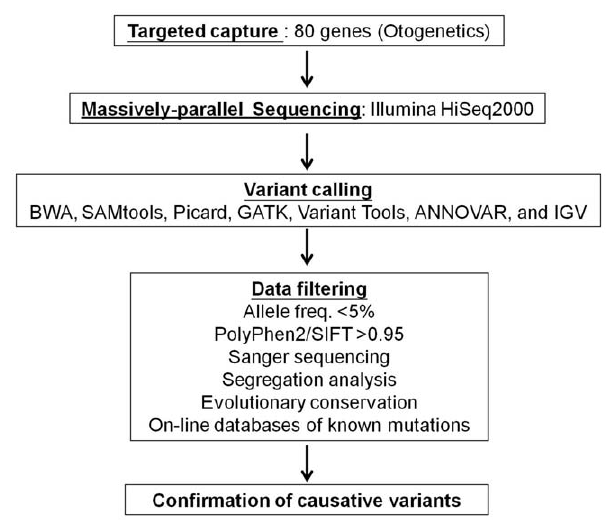
Figure 1. Pipeline to identify causative variants in the present study. Causative variants in the 12 families were confirmed through the steps of targeted capture of 80 known deafness genes; massively parallel sequencing with the Illumina platform; variant calling using the BWA, SAMtools, Picard, GATK, and IGV software packages; and data filtering with various criteria, including allele frequencies , 5% in both the 1000 Genomes Project and NHLBI-ESP 5400 exome project, both PolyPhen2 and SIFT scores . 0.95, Sanger sequencing, segregation pattern, evolutionary conservation of amino acid residues, and on-line databases of known deafness mutations.